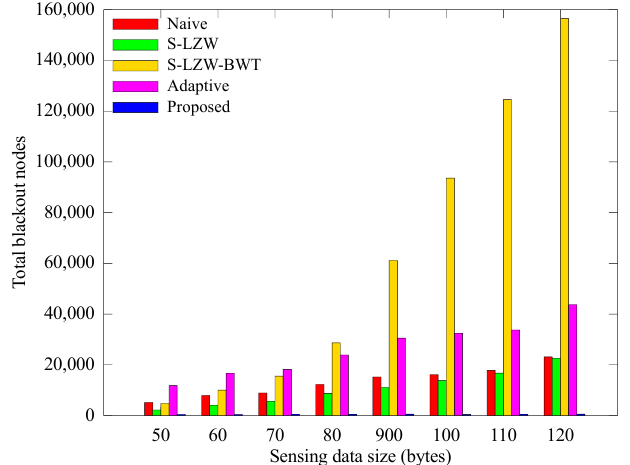
Figure 11. Comparison of the number of blackout nodes according to the sensing data size.